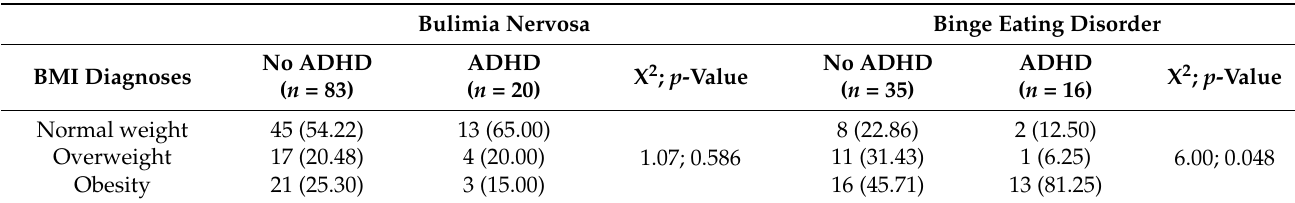
Table 3. Comparisons between BMI diagnoses in patients with BN and BED with the presence or absence of ADHD in the Mexican adolescent population. Bulimia Nervosa Binge Eating Disorder